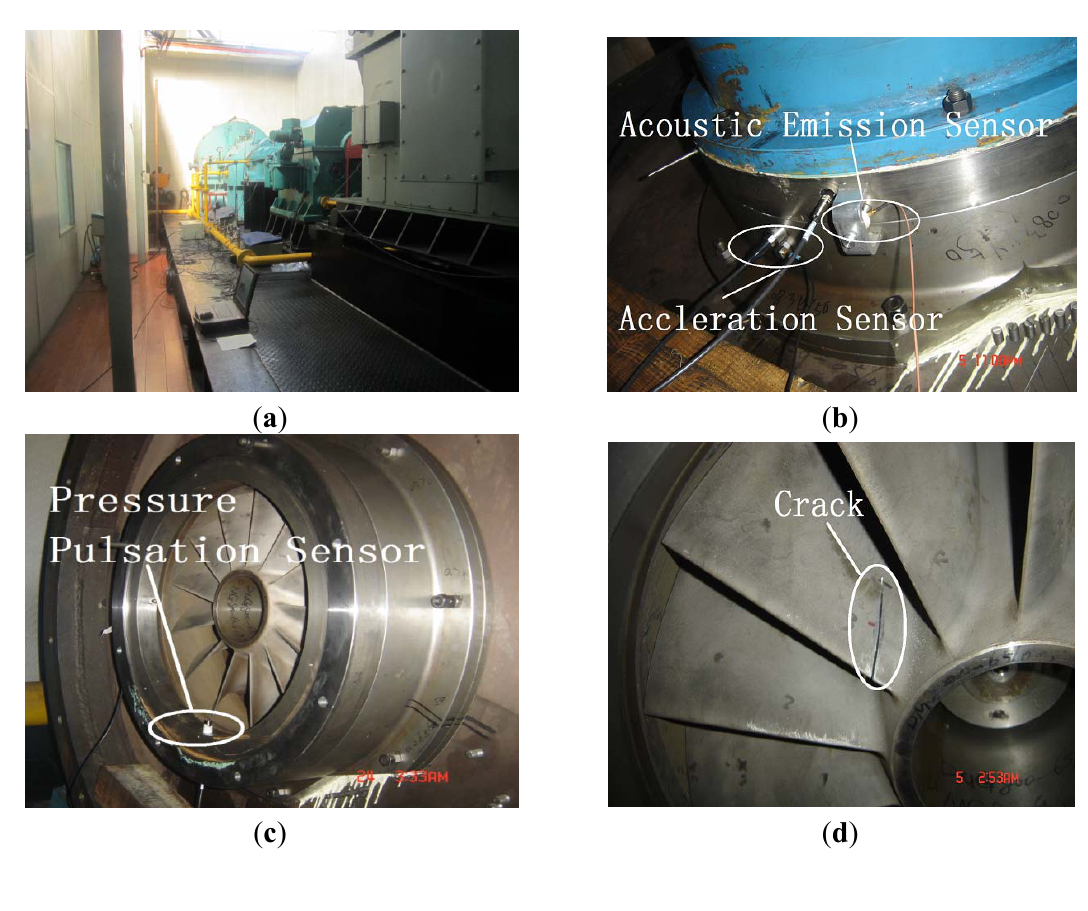
Figure 10. Pictures of the experiment. ( a ) Picture of test-rig; ( b ) Picture of transducer location; ( c ) Picture of blade monitoring; ( d ) Enlarged crack